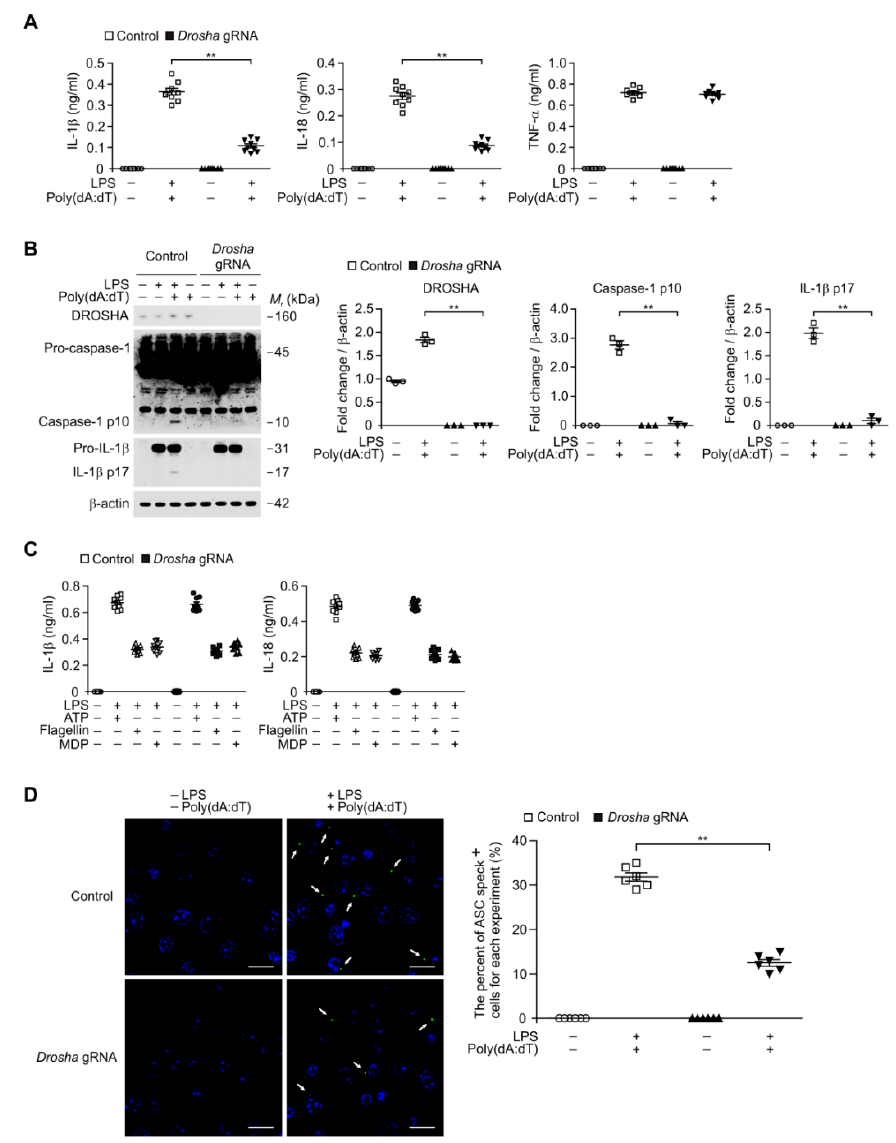
Figure 4. Deficiency of DROSHA suppresses AIM2 inflammasome activation in alveolar macrophages. ( A ) Quantification of interleukin (IL)-1 β (left), IL-18 (middle), and TNF- α (right) secretion from wild-type (WT) alveolar macrophages transduced with DROSHA-targeting gRNA ( Drosha gRNA), or with a control plasmid (Control), and stimulated with lipopolysaccharide (LPS) and poly(dA:dT). ( n = 9 mice per group). ( B ) Representative immunoblot analysis for caspase-1 and IL-1 β (left) and densitometry quantification of caspase-1 p10 and IL-1 β p17 levels (normalized to levels of β -actin) (right) from WT alveolar macrophages transduced with DROSHA-targeting gRNA ( Drosha gRNA), or with a control plasmid (Control), and stimulated with LPS and poly(dA:dT). For immunoblots, β -actin was used as loading control. ( n = 3 mice per group). ( C ) Quantification of IL-1 β and IL-18 secretion from WT alveolar macrophages transduced with DROSHA-targeting gRNA ( Drosha gRNA), or with a control plasmid (Control), and stimulated with LPS and either ATP, flagellin, or MDP ( n = 9 mice per group). ( D ) Representative immunofluorescence images (total 100 cells in 10 individual images per group) (left) and quantification (right) of ASC speck formation (white arrows) (the number of ASC speck positive cells in 10 individual images per group) in WT alveolar macrophages transduced with DROSHA-targeting gRNA ( Drosha gRNA), or with a control plasmid (Control), and stimulated with LPS and poly(dA:dT). ( n = 6 mice per group). Scale bars, 20 µ m. Data are mean ± SEM. ** p < 0.01; by Student’s two-tailed t -test or ANOVA.